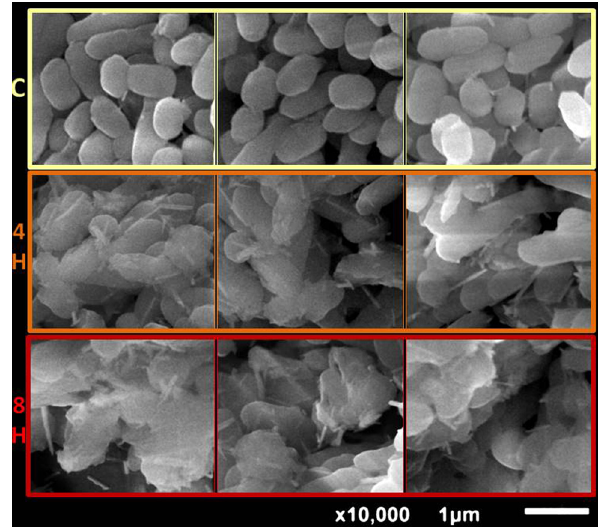
Figure 4: SEM micrographic examples of treated Sphingomonas paucimobilis by biosynthesized Se - NRs with pomegranate rind